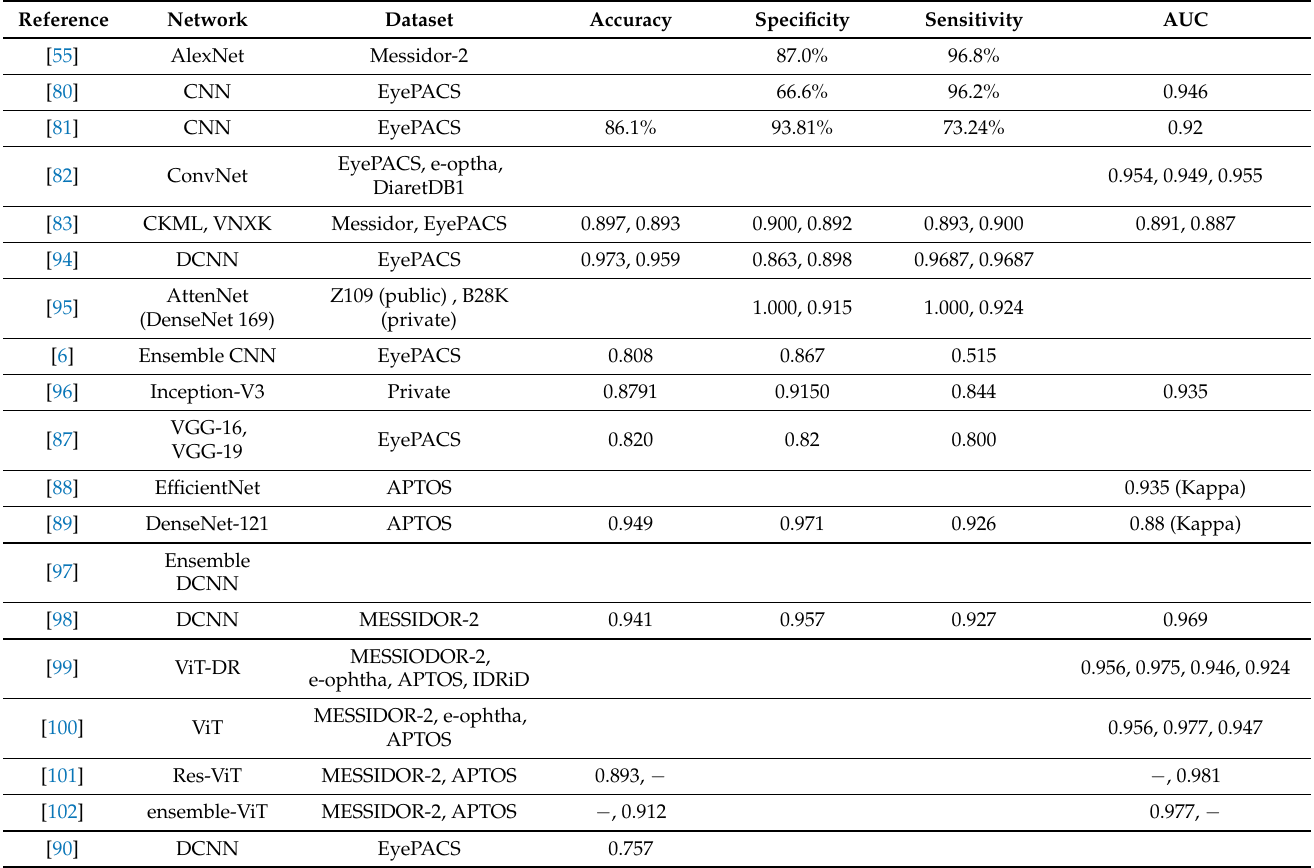
Table 3 is a summary of the DL-based models applied to detect diabetic retinopathy. Table 3. Summary of Deep Learning Methods for DR